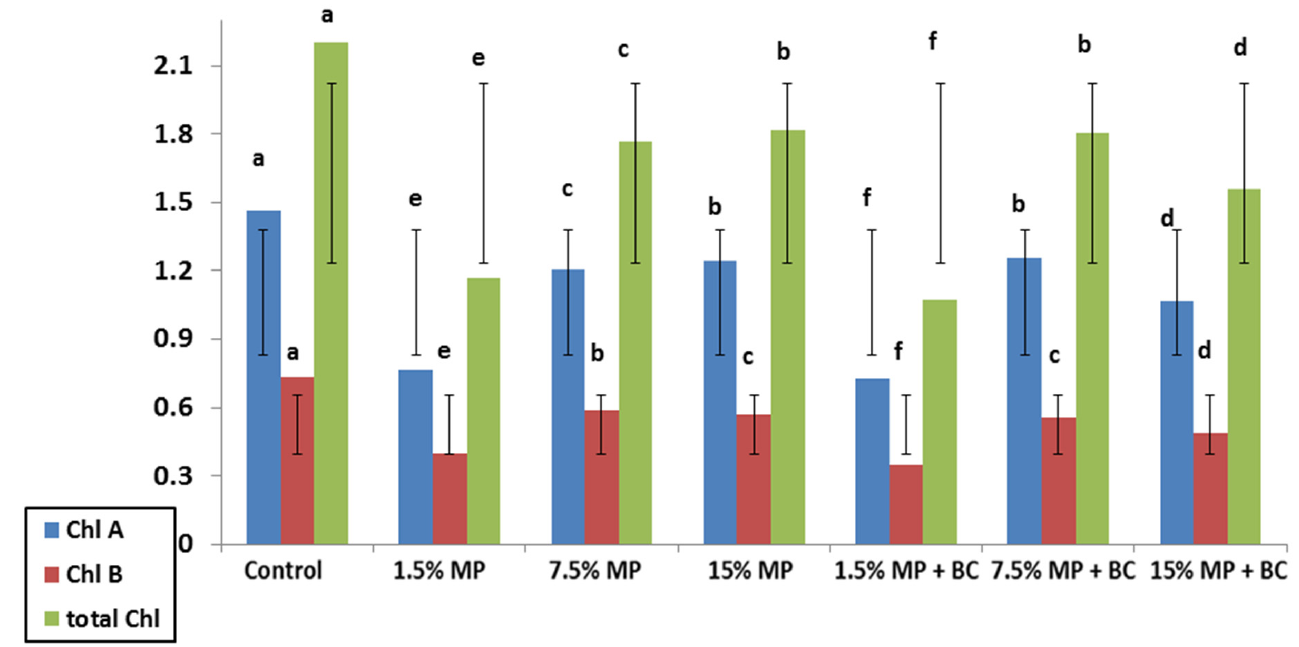
Figure 2. Biochar effect on the chlorophyll content in Vicia faba plants affected by microplastic in soil. Different letters in each column indicate significant difference at p < 0.05 (based on Duncan test) between treatments